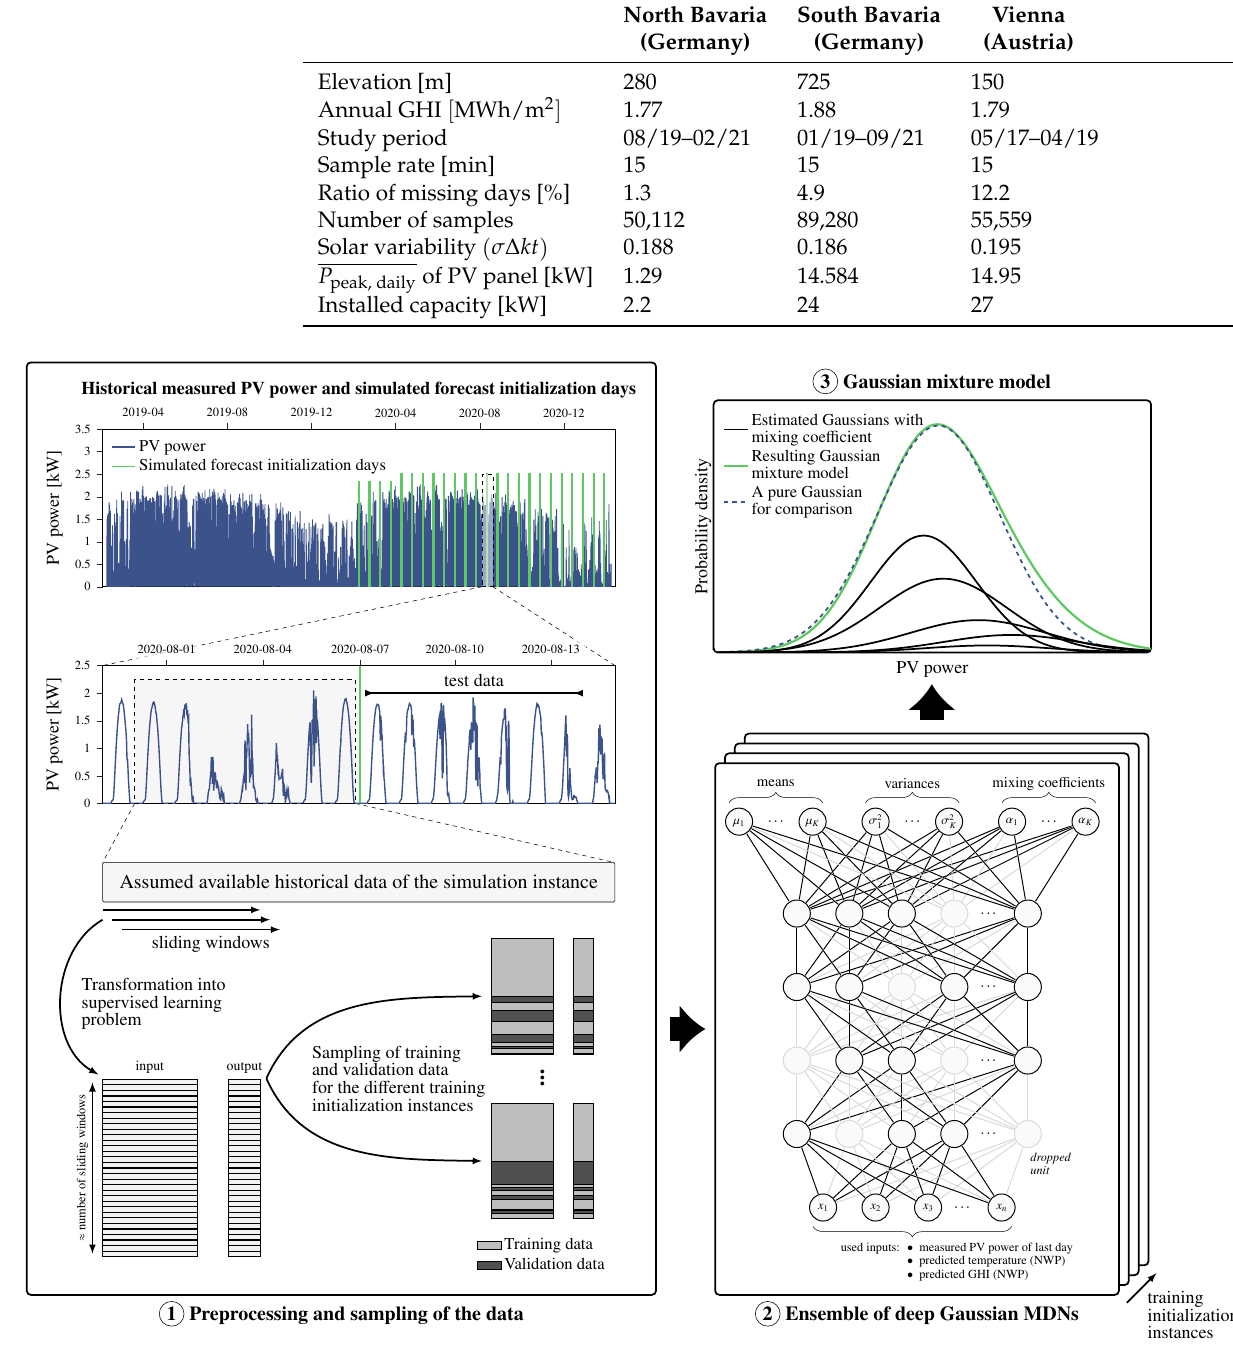
Figure 2. Schematic illustration of the performed forecast approach. For each of the 24 different simulated forecast initializations, the past data (7 or 182 days) are used to train the model 1 (cid:13) . To estimate the epistemic uncertainty, MC dropout and multiple training initializations with different samples of training and validation data are used 2 (cid:13) . Subsequently, the ensembles of Gaussian distributions estimated by the Deep Mixture Density Networks are combined according to their mixture coefficients to estimate the overall forecast uncertainty 3 (cid:13) . With a sufficient number of hidden units and a sufficient number of mixture distributions, this approach can theoretically approximate any probability distribution